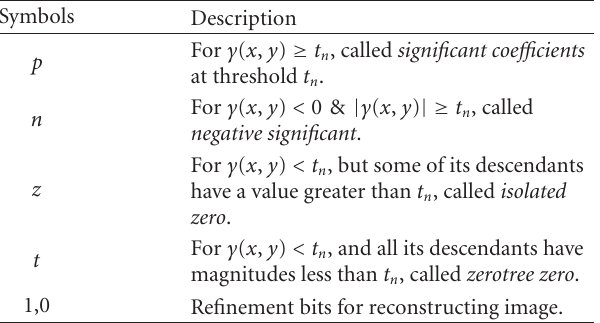
Table 1: Definition of